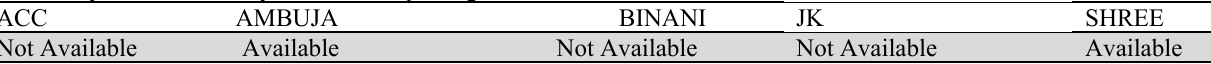
Availability of Sustainability Financial